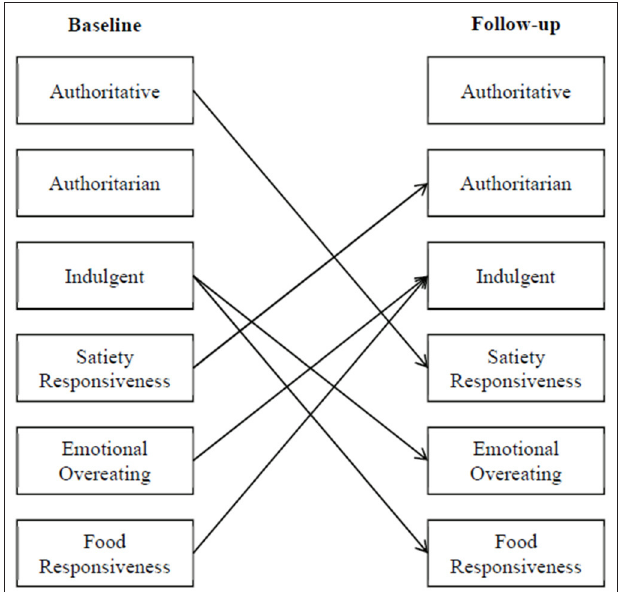
FIGURE 1 | Conceptual model depicting hypothesized paths.